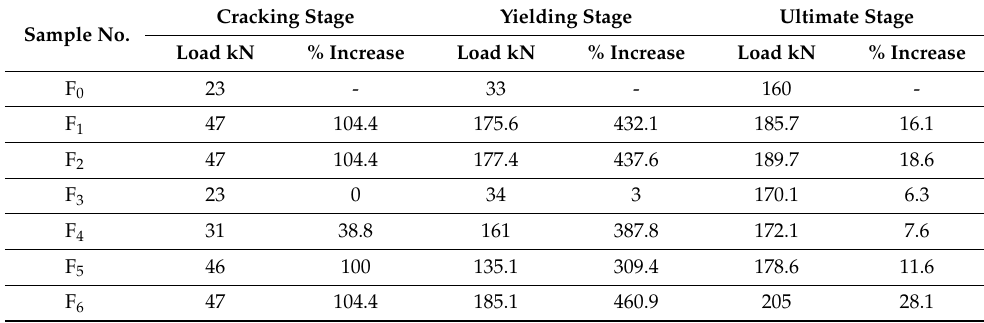
Table 3. Summary of the load capacity analysis.